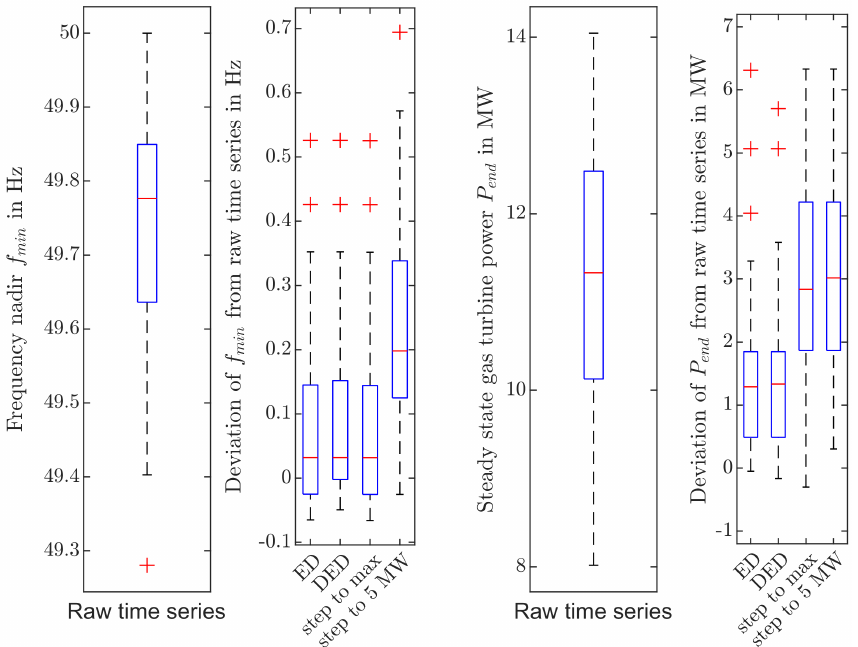
Figure 13. Distribution of fitted model parameters: Red crosses are outliers beyond 1.5 time the interquartile range. Distribution of frequency nadir and deviation of frequency nadir and steady- state power in recorded time series and respective deviation using ED or DED CLPU models or approximating load steps to the steady-state value of 5MW or the maximal value ( a + 1 ) · 5MW,